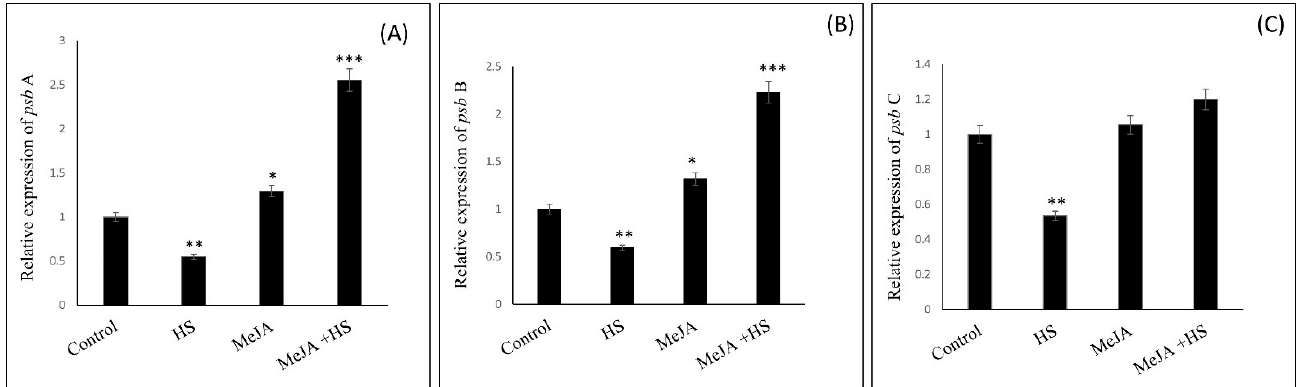
Figure 5. Relative expression of the genes ( A ) psb A; ( B ) psb B, and ( C ) psb C in wheat leaves at 30 DAS. Plants were treated with MeJA (10 µM) at 42 °C (heat stress) or 25 °C (no stress). Results are presented relative to the respective controls (control, 1). Data are presented as mean ± SE ( n = 4). Significantly different values between control and treatments are marked with an asterisk (* p < 0.05, ** p < 0.01, *** p < 0.001), as determined by Tukey’s test. DAS, days after sowing; HS, heat stress; MeJA, methyl jasmonate.